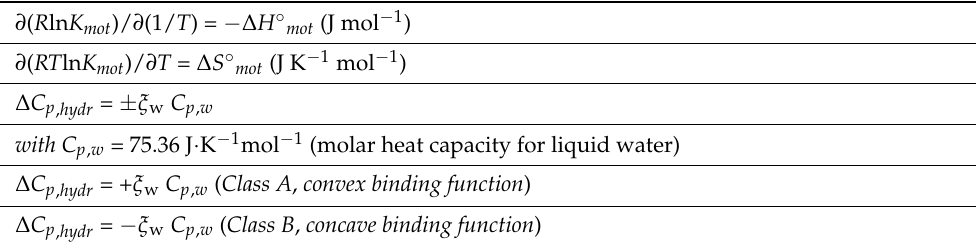
Table 1. Information elements from EAM